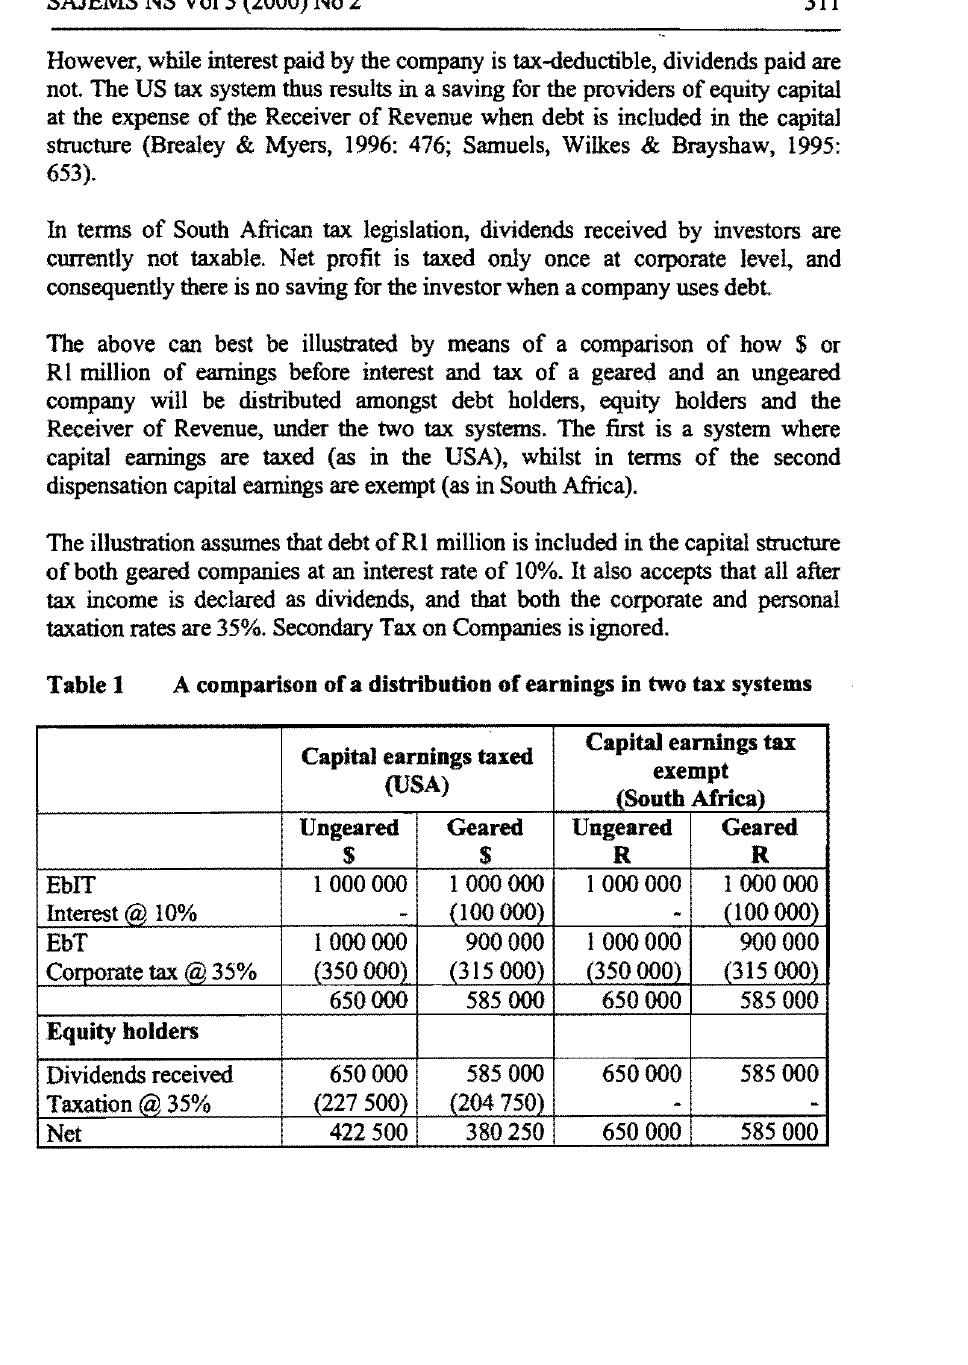
A comparison of a distribution of earnings in two tax systems Capital earnings taxed (USA)